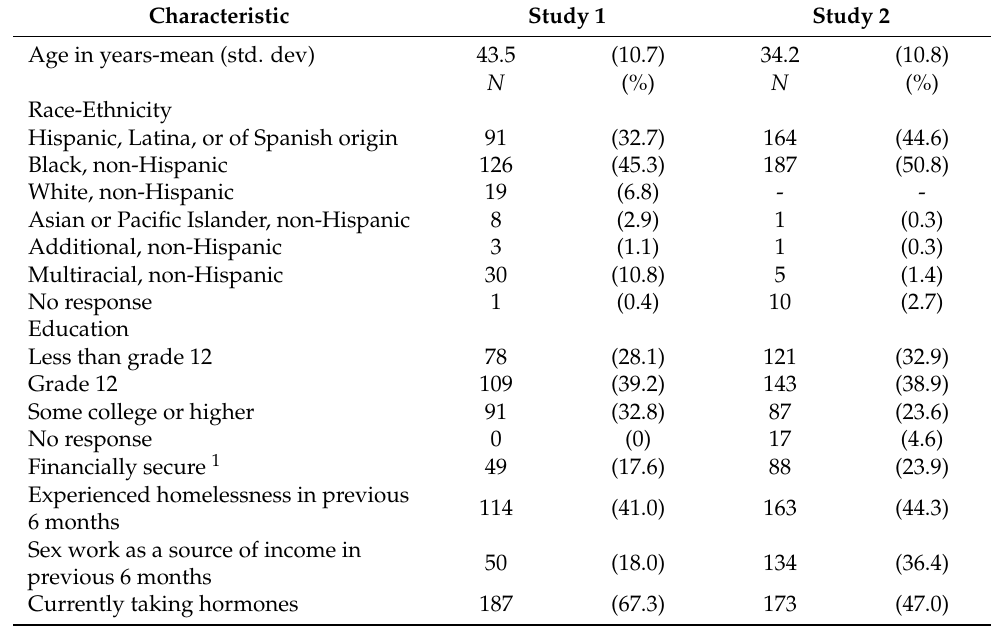
Table 1. Descriptive characteristics of participants in Study 1 ( N = 278) and Study 2 ( N =